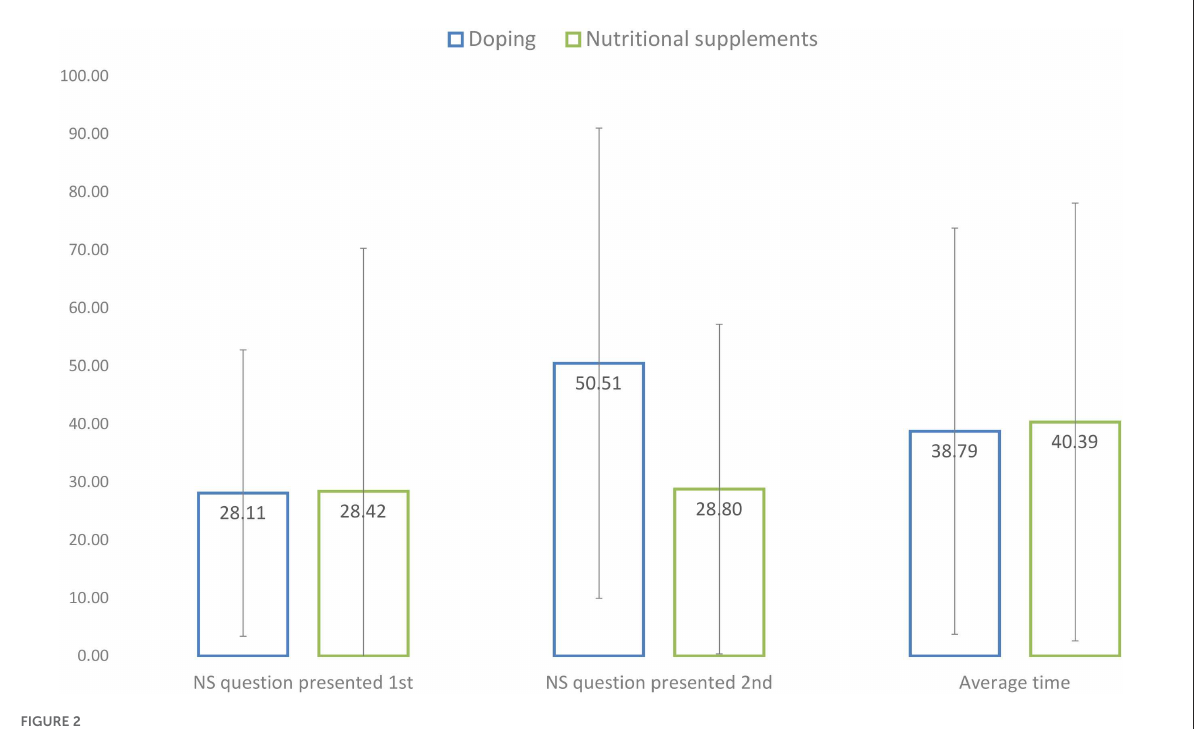
FIGURE2 Mean response times for completing the SSC survey model at